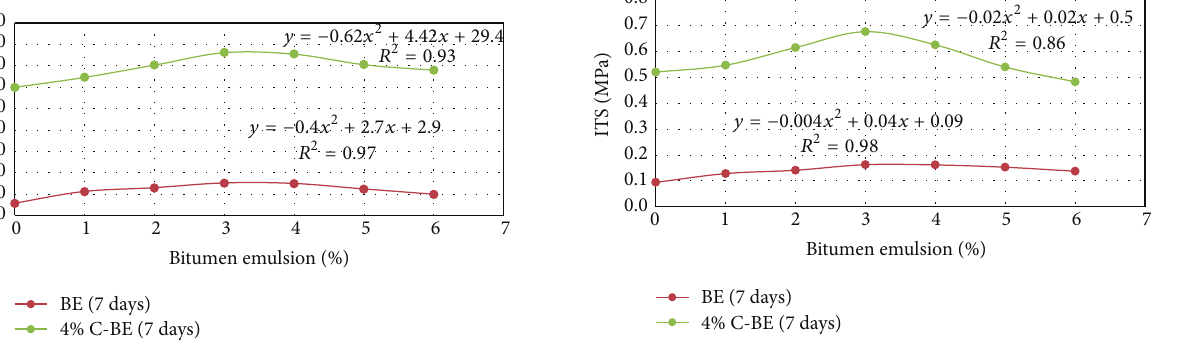
Figure 5: Influence of bitumen emulsion content on ITSs of BETB and